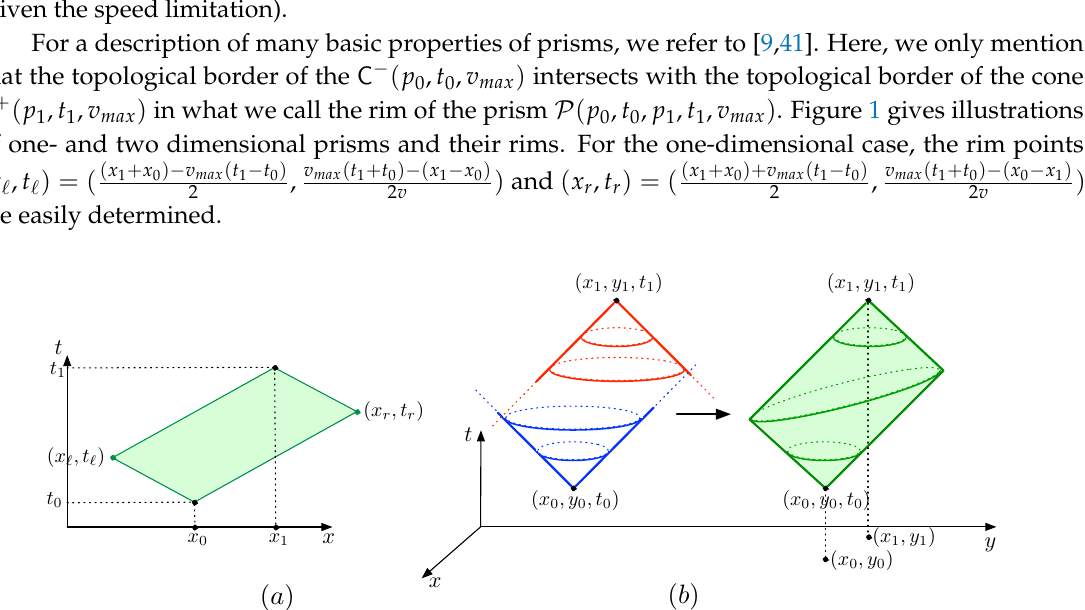
( x 0 , t 0 , x 1 , t 1 , v max ) with its rim points in green P ( x 0 , y 0 , t 0 , x 1 , y 1 , t 1 , v max ) (in green) is shown for P ( x 0 , y 0 , t 0 , x 1 , y 1 , t 1 , v max ) is the tilted green P